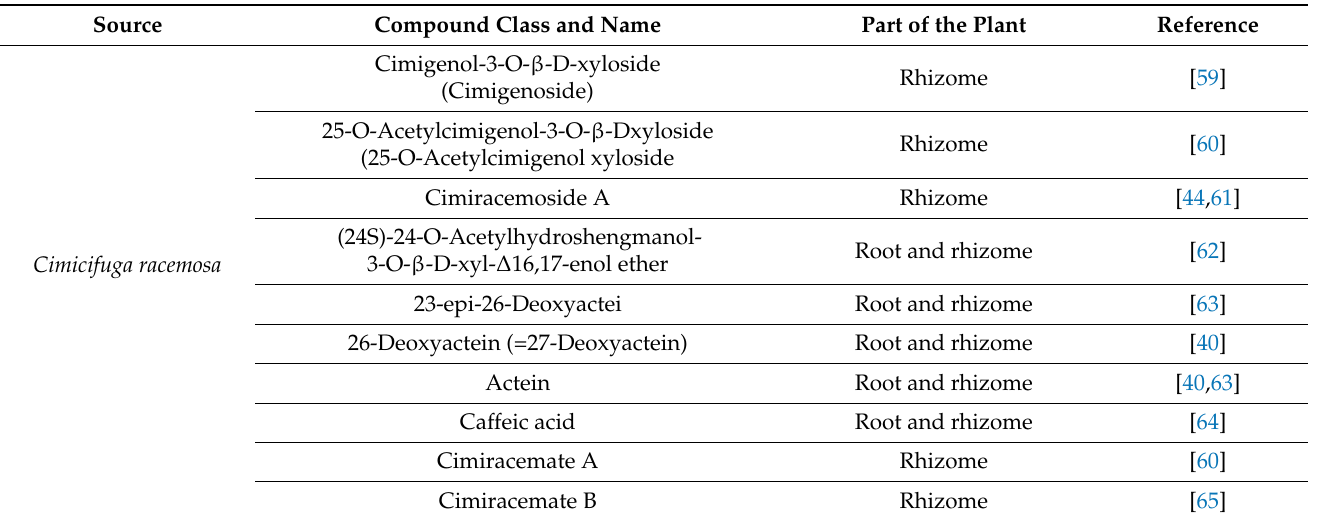
Table 3. Pharmacologically active constituents of CR.